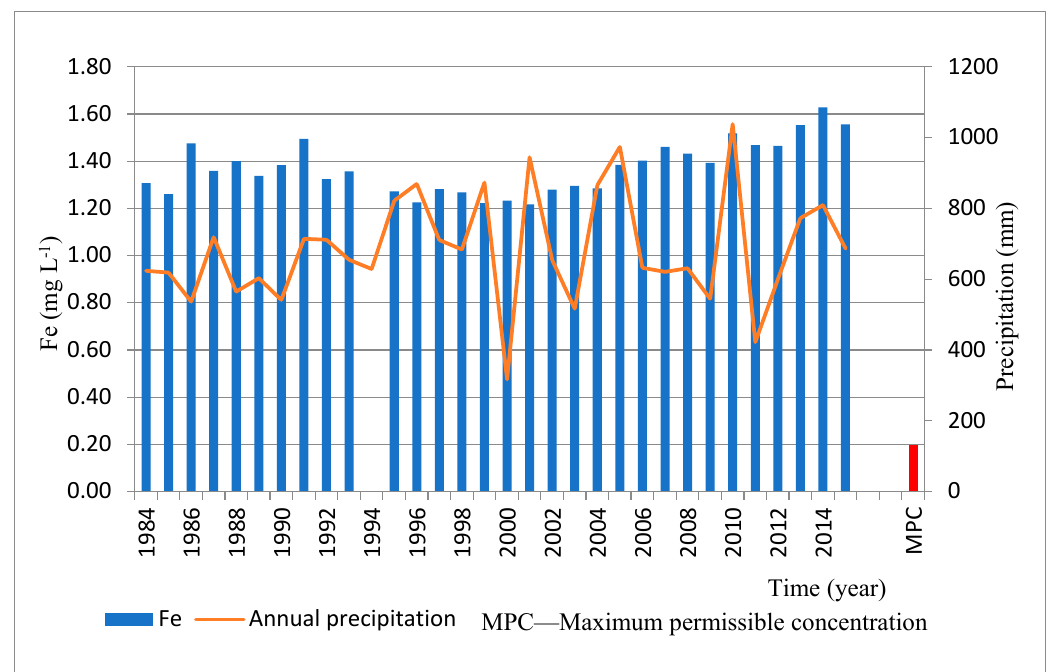
Figure 13. Concentrations of iron in groundwater sampled at the Vinogradi pumping station, Osijek, Croatia in the period 1984–2015.